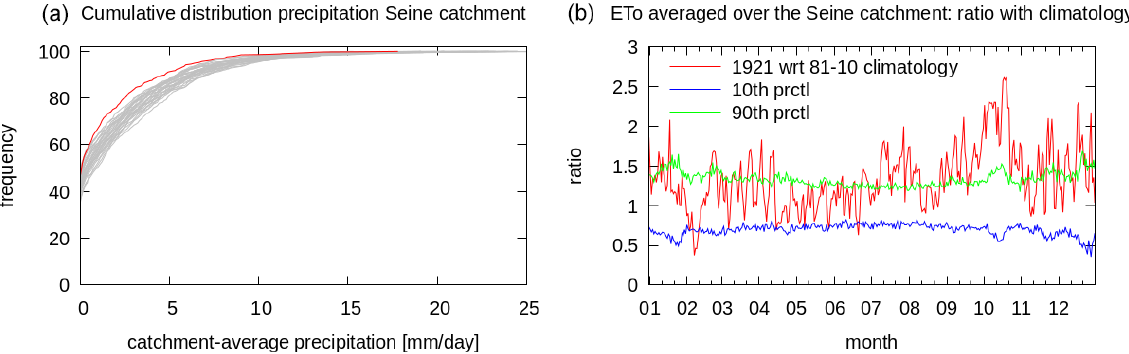
Figure 8. Cumulative distribution of daily rainfall aggregated over the Seine catchment (a) . In red the data from the 1920–1921 period; the grey lines show individual years in the 1981–2010 period. Panel (b) shows estimates of ET 0 for 1921 averaged over the Seine catchments as ratios to the 1981–2010 climatology. Added in blue and green are the 10th and 90th percentile of ET 0 values from the 1981–2010 climatology, again as a ratio from the mean value. Based on the E-OBS dataset.